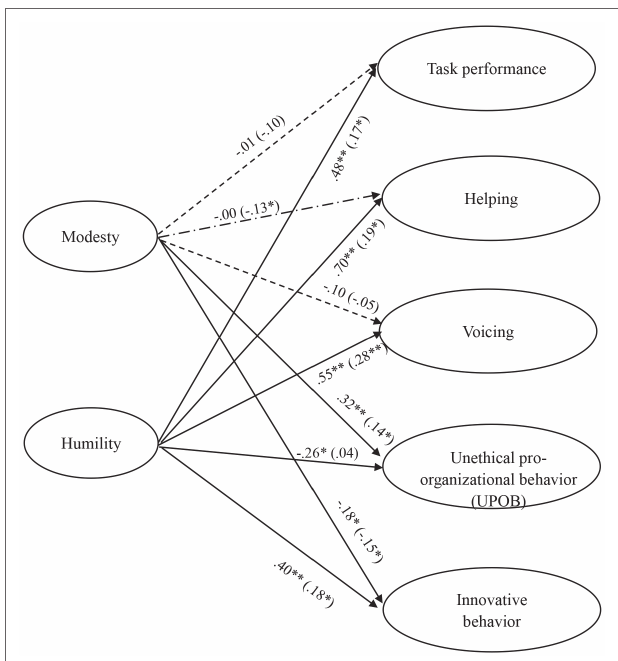
FIGURE 2 | SEM Results for the hypothesized model. (1) The values outside the brackets are the path coefficients for the supervisor-rated outcomes; the values in brackets are the path coefficients for the employee self-rated outcomes. All the coefficients are standardized. (2) We controlled for age, gender, education, and organizational tenure for all outcome variables. For simplicity, we do not show the coefficients here. (3) ** p < 0.01 and * p <